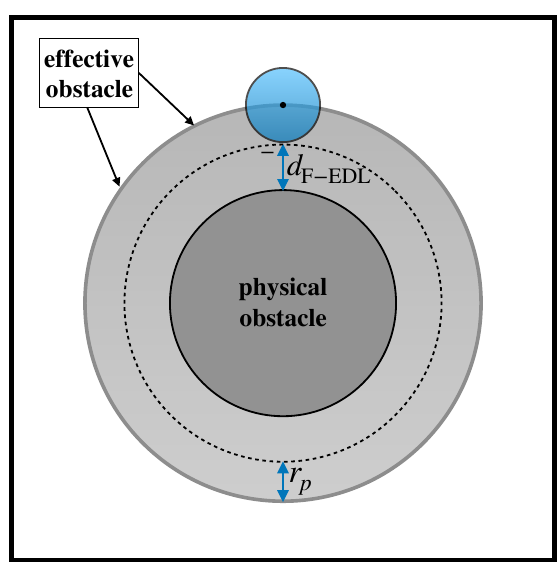
Figure 7. Effective obstacle approach accounting for electrostatic effects and particle hindrance. Outside the effective obstacle, a finite-sized particle is thought of as a point tracer collapsed at its center, which passively follows the streamlines of the unperturbed flow. At the effective obstacle boundary, the effect of the obstacle is such as to preserve the tangential velocity of the particle while annihilating the component normal to the